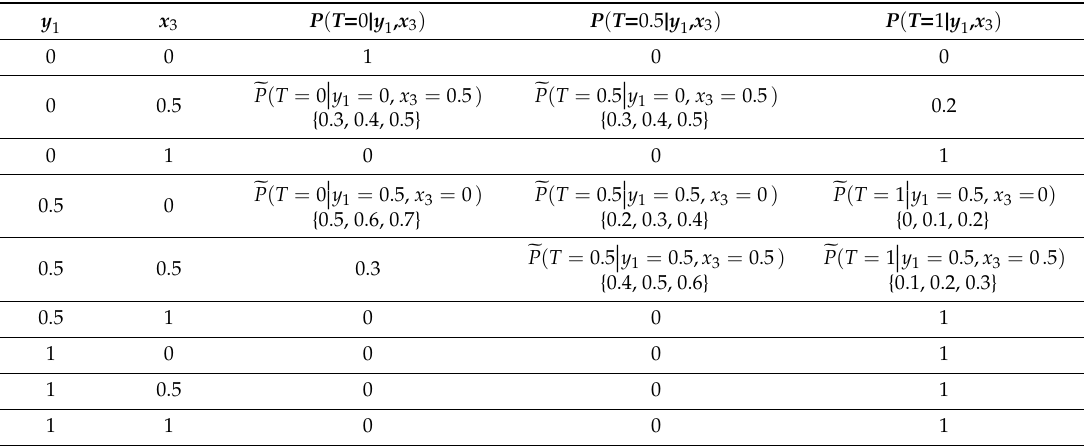
Table 3. CPT of leaf node T .